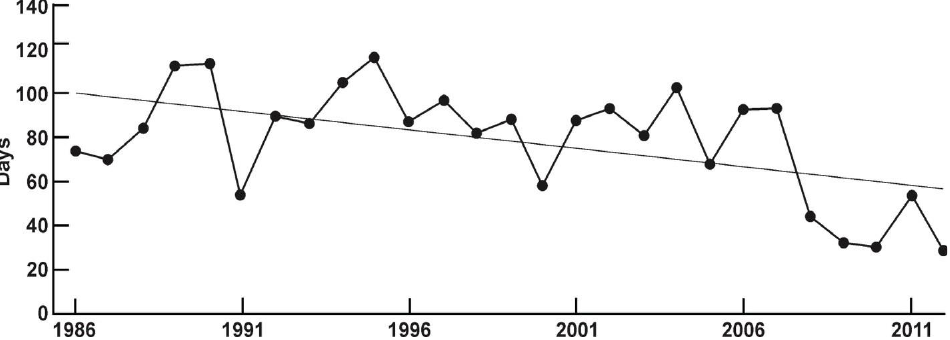
Figure 6. Duration of floods on Upa River (Orlovo gauging observation point). Straight sloping line indicates change trend [81]. indicates change trend